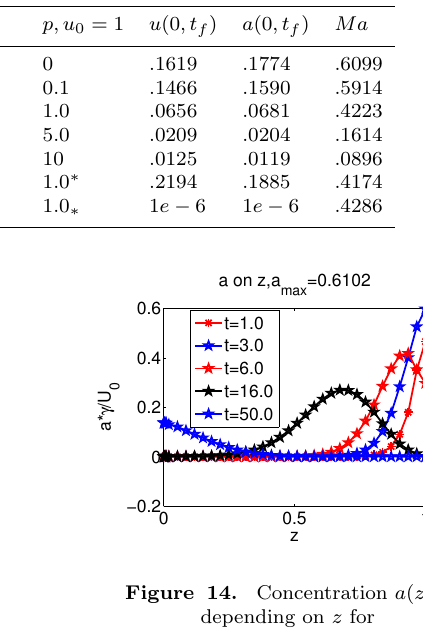
Figure 14. Concentration a ( z,t ) depending on z for t = 1;3;6;16;50 ,u 0 = 0 , ˜ p =